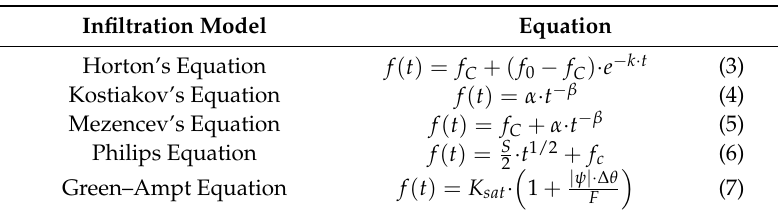
Table 4. Infiltration models used in the